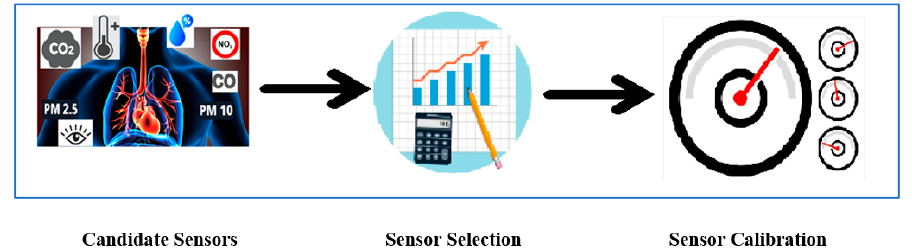
Figure 1. Process diagram for data-driven sensor calibration methodology to build air quality monitoring devices.